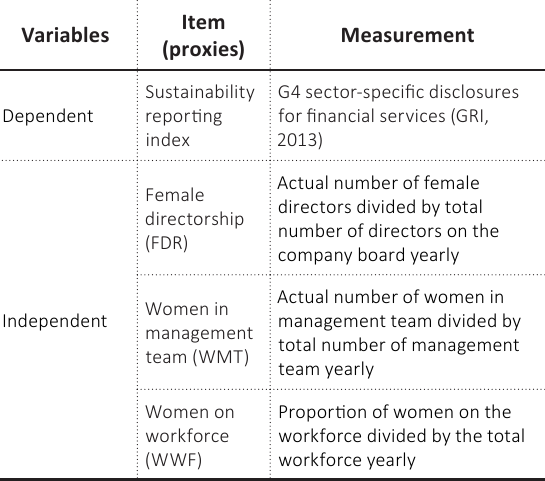
Table 1. Measurement of